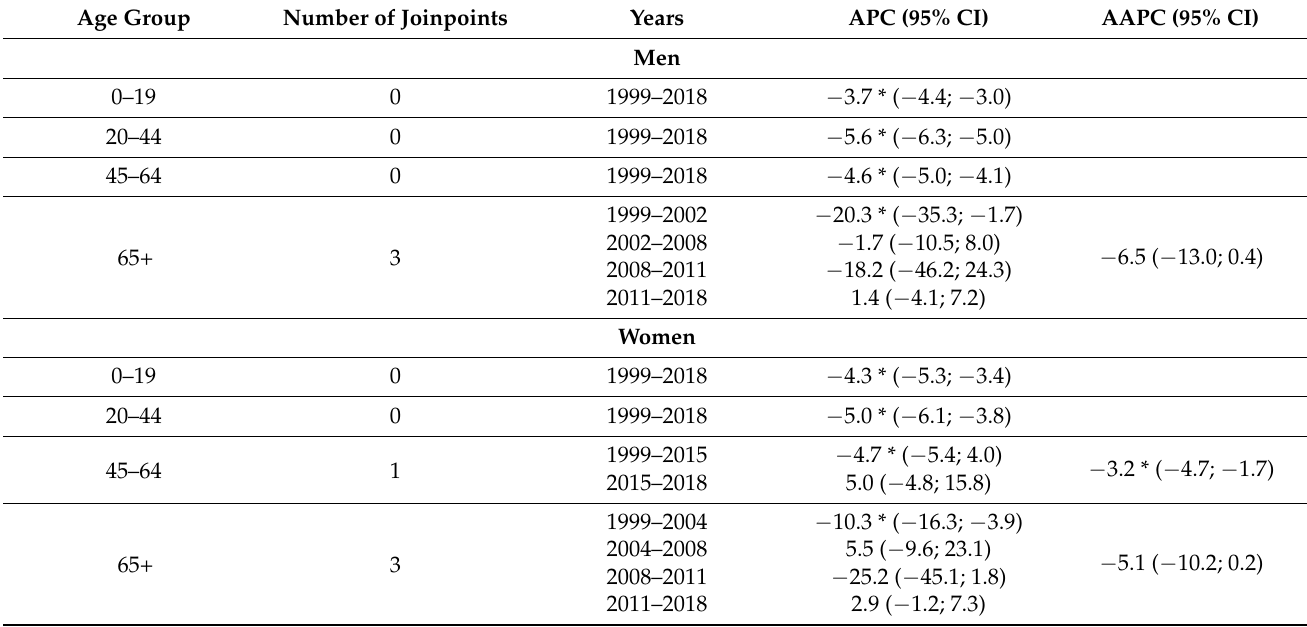
Table 4. Time trends of SDR due to road traffic injuries in 1999–2018 in Poland by sex and age groups—joinpoint regression